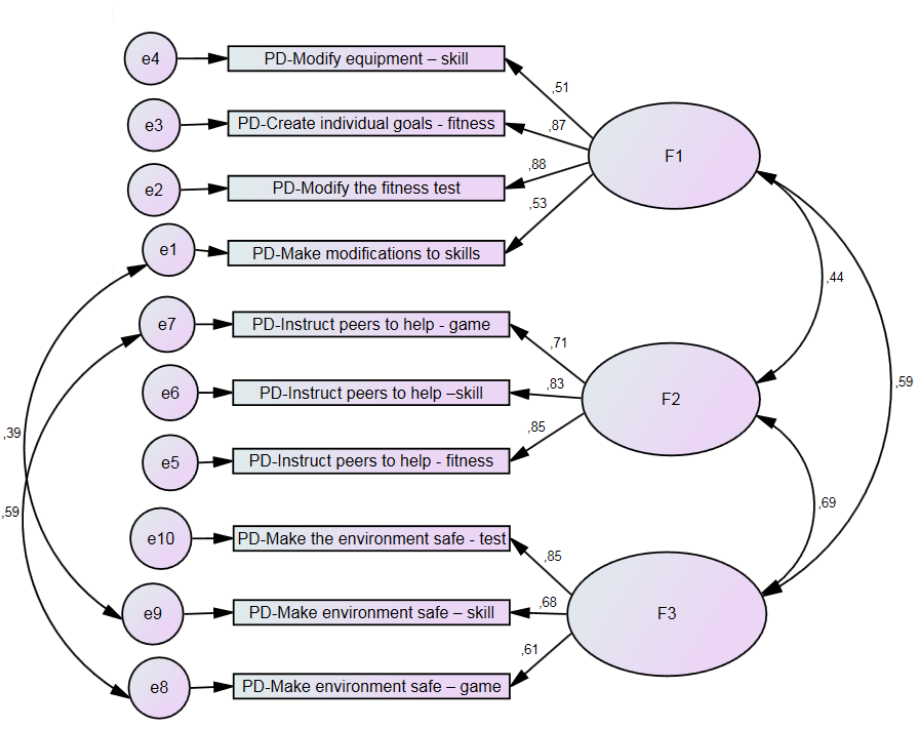
Figure 2. Path diagram of physical disability